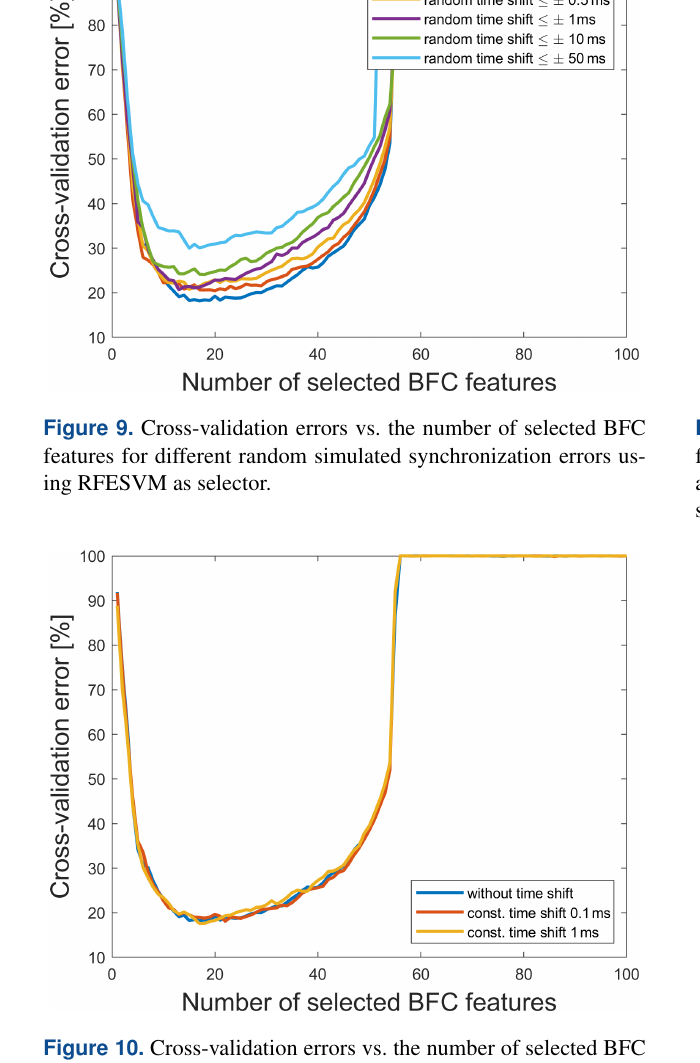
Figure 12. Best feature according to RFESVM (120Hz of the ac- tive current) for the 2kHz raw data set and the data set with random time shift of maximum 50ms for three different